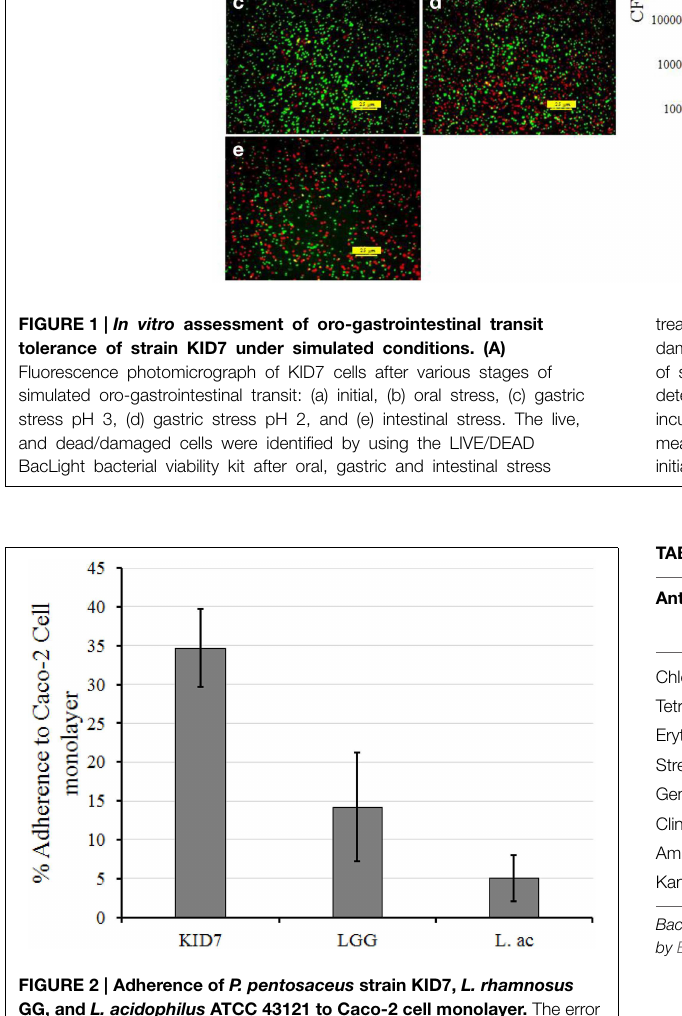
FIGURE 2 | Adherence of P. pentosaceus strain KID7, L. rhamnosus GG, and L. acidophilus ATCC 43121 to Caco-2 cell monolayer. The error bars indicate standard deviation of three independent experiments.